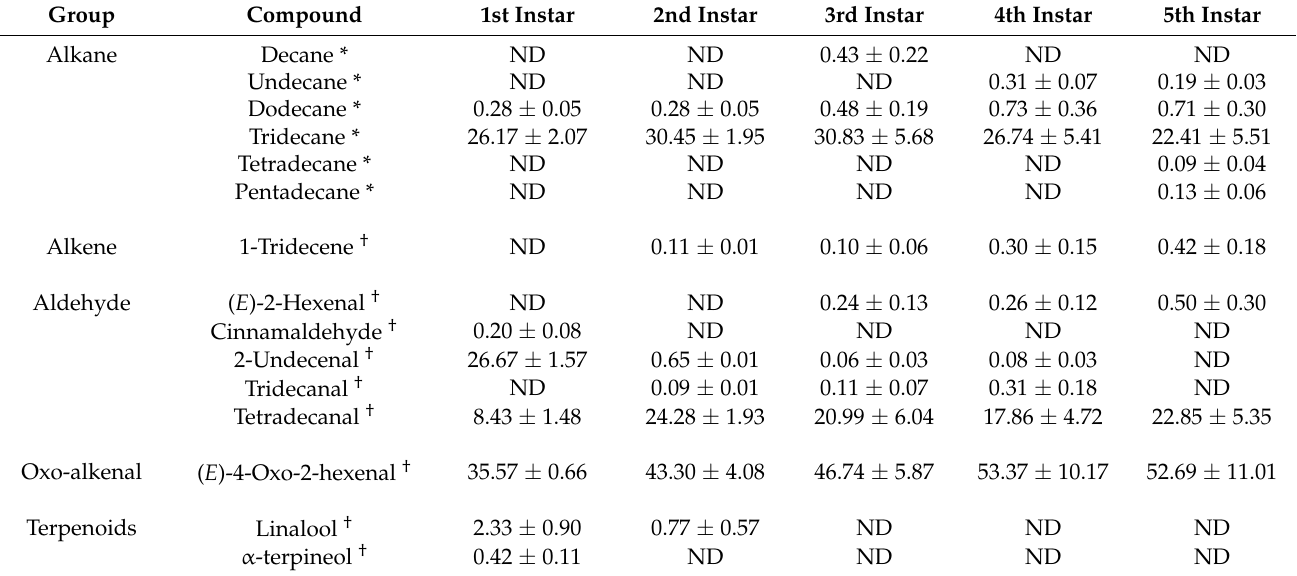
Table 2. Relative abundance (%) (mean ± SE) of different compounds present in the exuviae of the dorsal abdominal gland extracts of first through fifth instars of the rice stink bug, Oebalus pugnax